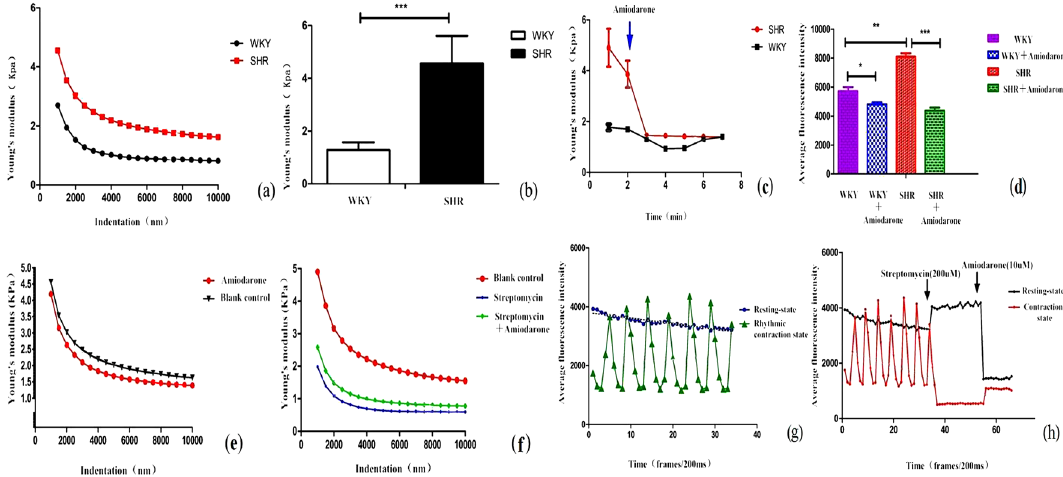
Figure 1. The effect and mechanism of amiodarone on ventricular myocytes in vitro. ( a ) Stiffness variation trend of ventricular myocytes in SHR and WKY at different indentation depths. ( b ) Young’s modulus of SHR ventricular myocytes vs. Young’s modulus of WKY ventricular myocytes. ( c ) Comparision of amiodarone’s effect on the stiffness of ventricular myocytes in SHR group and WKY group: amiodarone was given within the second minute, Young’s modulus of both groups decreased, but SHR decreased more significantly. ( d ) Comparison of amiodarone’s effect on the stiffness of ventricular myocytes in SHR group and WKY group: amiodarone was given within the second minute, the average fluorescence intensity of both groups decreased, but the average fluorescence intensity of SHR group decreased more significantly. ( e ) Effect of amiodarone on stiffness of ventricular myocytes: comparison of stiffness before and after amiodarone added. ( f ) Effect of amiodarone on ventricular myocyte stiffness under streptomycin blocked. ( g ) Changes of intracellular mechanism of amiodarone on intracellular Ca 2+ concentration in ventricular myocytes in resting state and rhythmic contracting